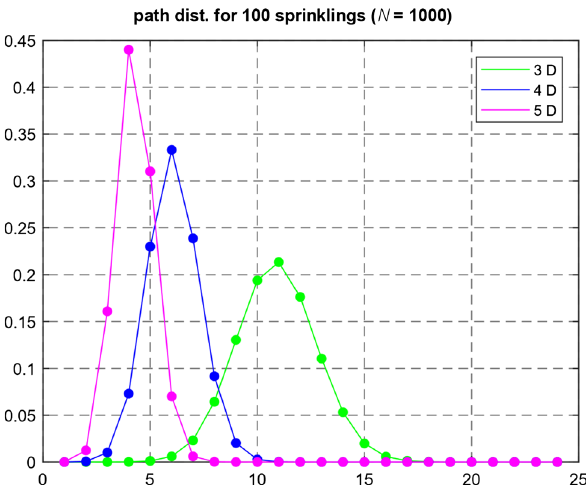
Fig. 8 Probability distributions for path lengths in 3-, 4- and 5- dimensional Minkowski space, obtained by normalizing the average distributions from 100 sprinklings of N = 1000 points in each